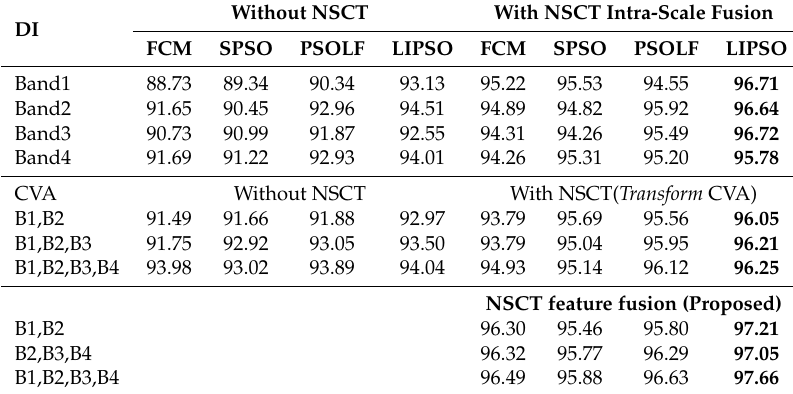
Table 5. OA obtained for FCM [3], SPSO [47], PSOLF [43], LIPSO (proposed) of Dubai City data set; OA = Overall accuracy.